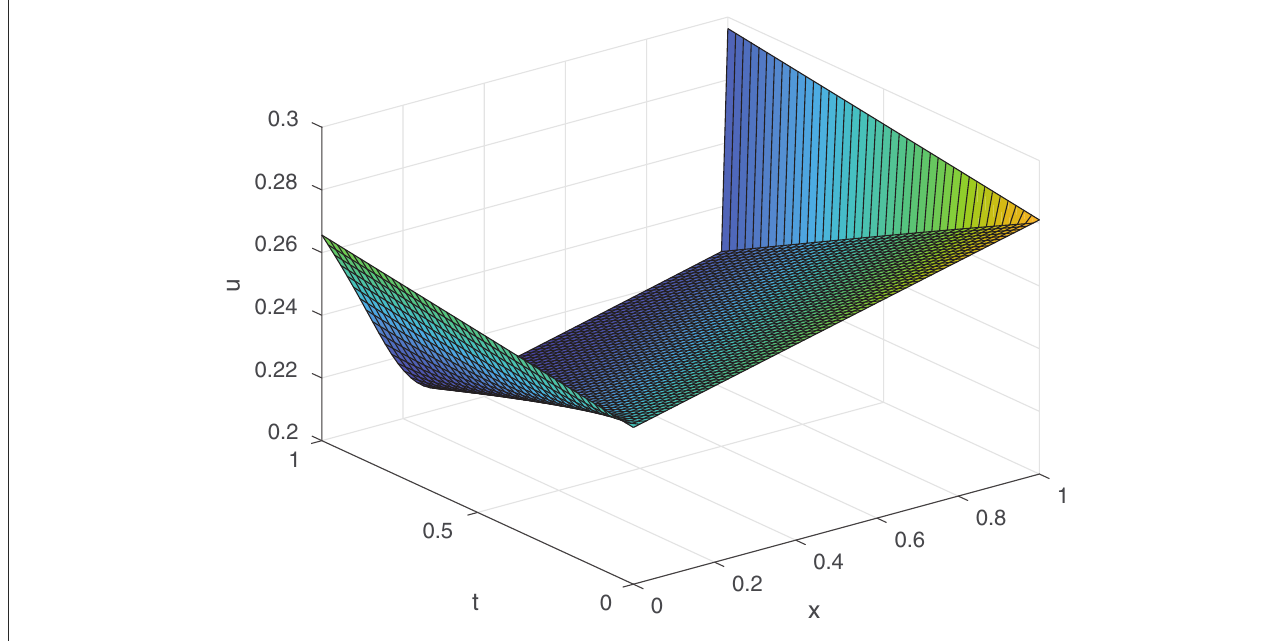
FIGURE1 Numerical solutions of Example 4.1 using the proposed method for T = 1, M = 64, N = 40 and ε = 10 − 4 . A layer is observed near x = 1.